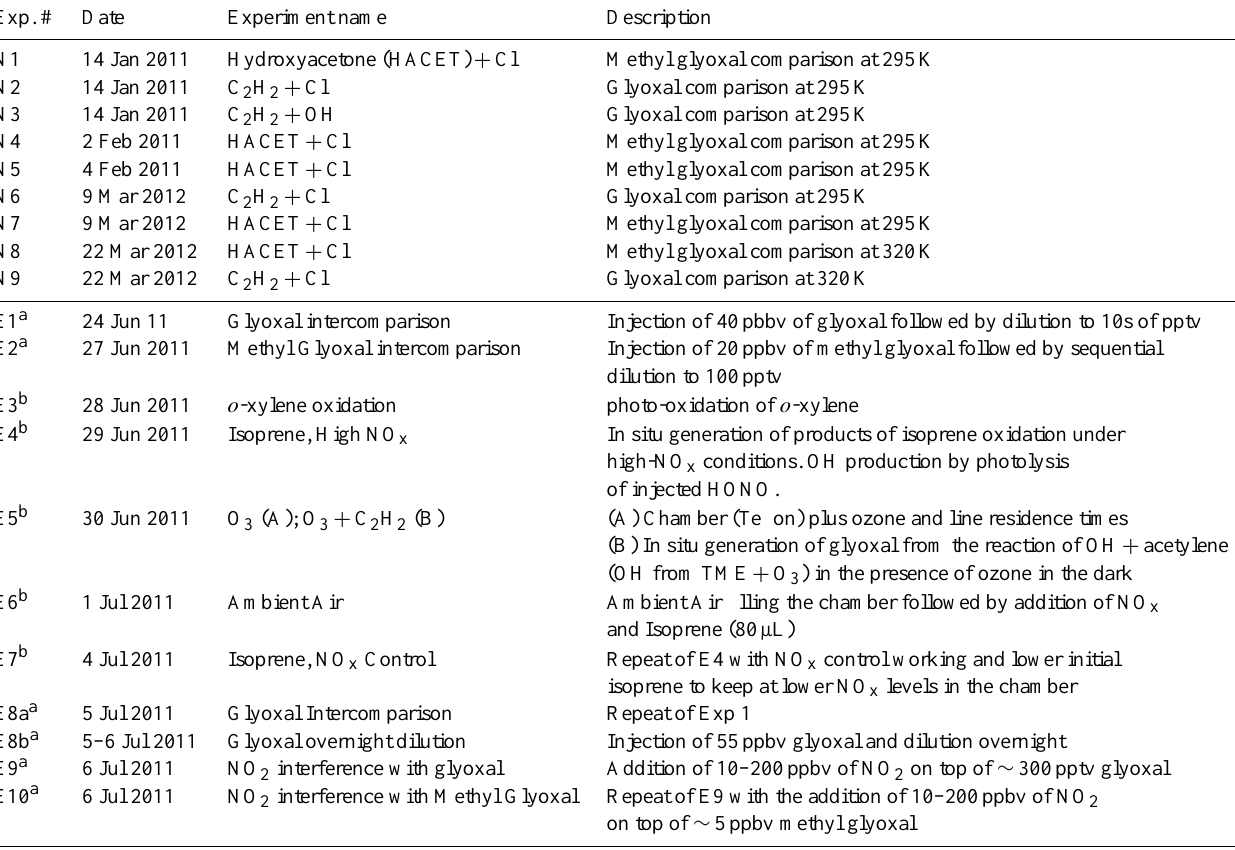
Table 2. Overview and description of experiments at NCAR (N) and EUPHORE (E.) Exp.